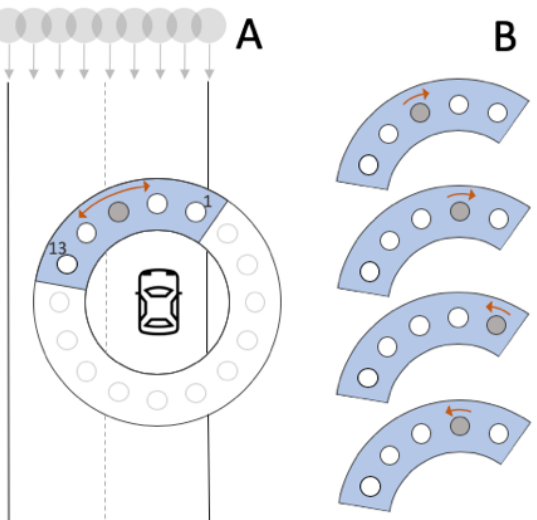
Figure 3. Uncertainty signal for an object approaching from the front on a two-lane road ( A ). Grey dots indicate possible locations of the approaching vehicle as signaled by the system. The stimulus traveled between the borders and bounced back in the other direction as it hit one of the borders ( B ). The width of the range was chosen to be between the vibromotors that were allocated for the static signal (Figure 2) plus one extra vibromotor on each side. Thus, in the example in this image, the signal bounced between vibromotors 13 and